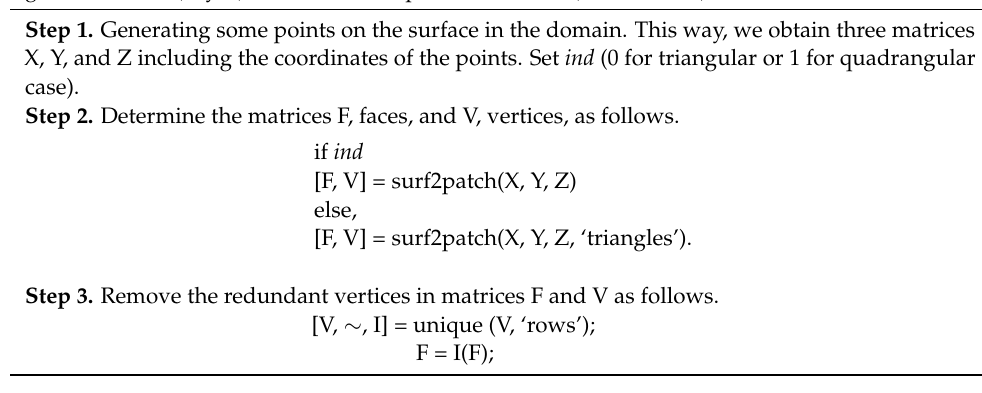
Algorithm 1. Generating initial triangular or quadrangular gridshells (matrices F and V) for